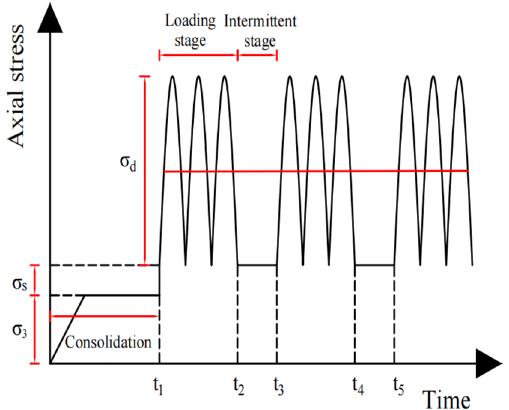
Figure 1. Intermittent cyclic load